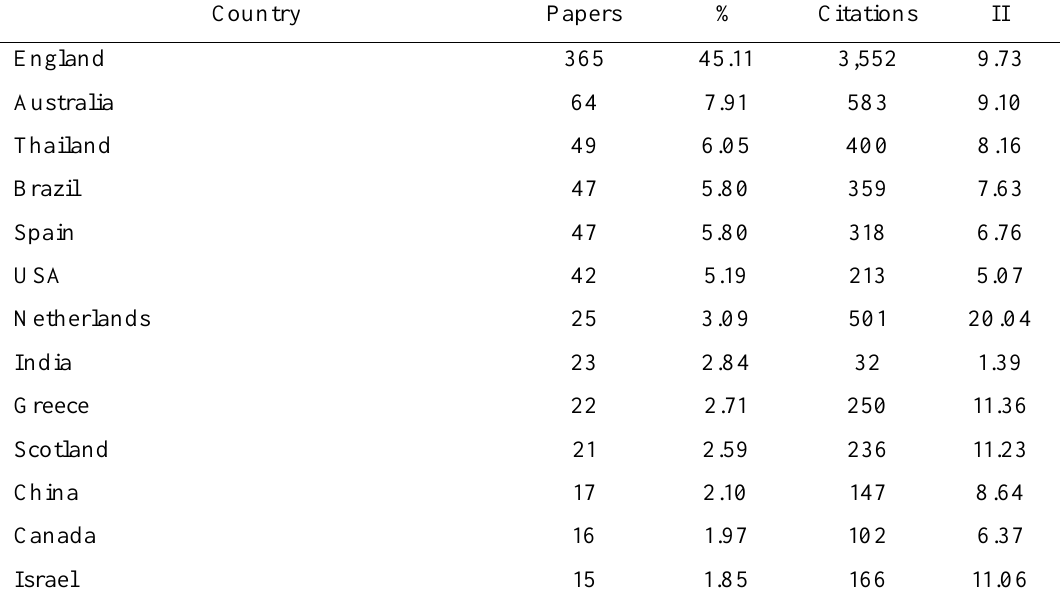
Countries With the Most Output on OUs